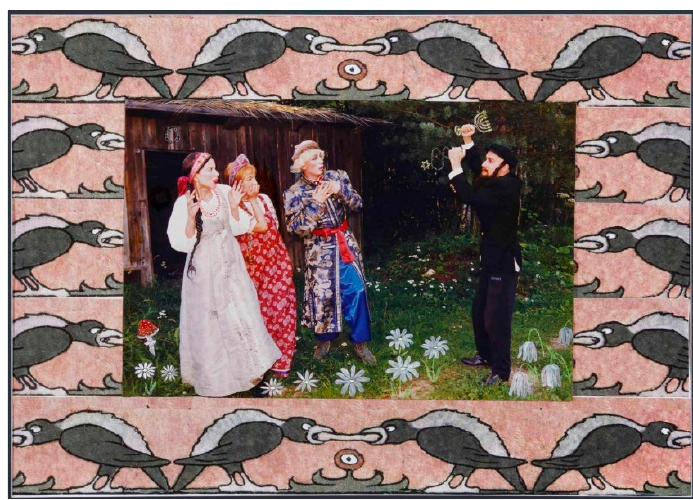
Figure 6. Vlad Mamyshev-Monroe. From the series “The Russian Questions” (1997), https://vmmf.org/series/view?id=6#work-series-6-3 (accessed on 11 September 2022).